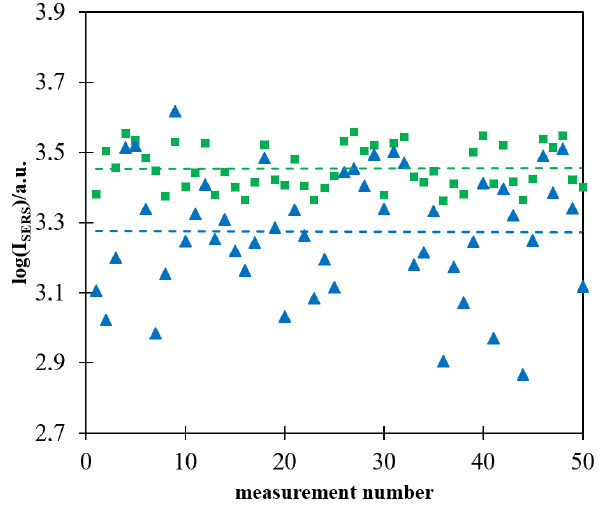
Figure 7. Logarithm of the intensity of the strongest Raman band at 1587 cm − 1 in the spectrum of the Pt/p-MBA monolayer covered by the (Fe 3 O 4 @Ag)@SiO 2 nanomaterial in each of 50 subsequent measurements: ( ■ ) evaporation of the solvent performed when the sample was placed in a strong magnetic field, ( ▲ ) evaporation of the solvent performed without application of a strong magnetic field. The dashed lines show the average values calculated from 50 measurements. The wavelength of the excitation radiation: 532 nm. The power of the laser beam on the laser head: 70 mW. The accumulation time for a single Raman spectrum: 10 s.